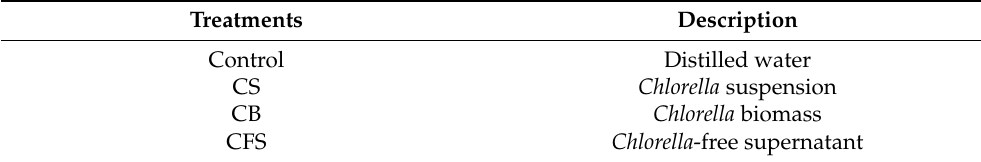
Table 1. Chlorella treatments used in this study.